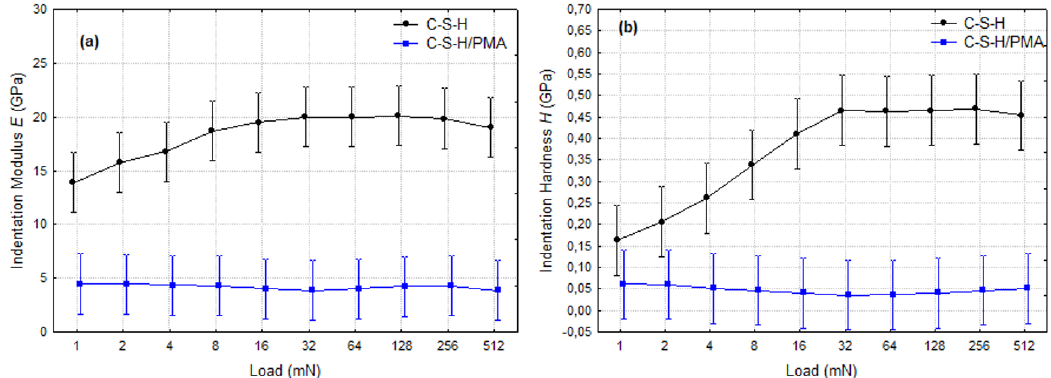
Figure 8. Elastic modulus - E (a) and hardness - H (b) vs applied load - P of C-S-H and C-S-H/PMA until 512 mN (matrix 2).